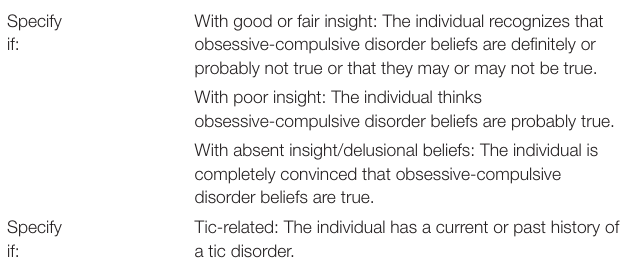
TABLE 1 | DSM5 OCD specifiers relevant to pediatric